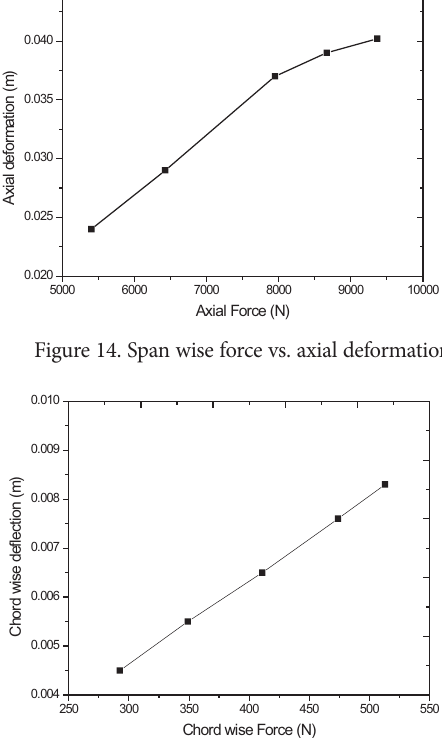
Figure 15. Chord wise force vs. chord wise